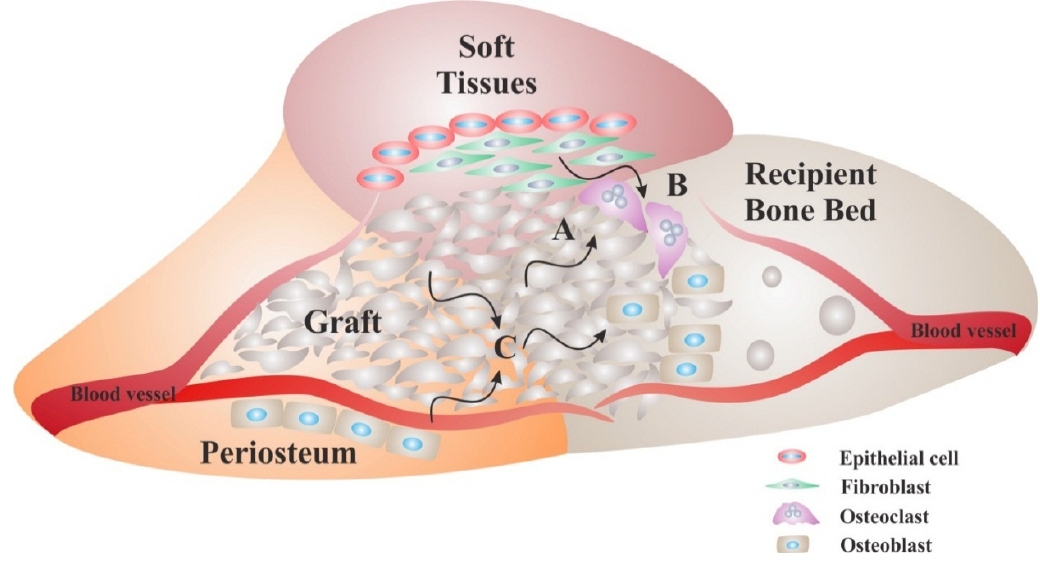
Figure 2. Biological requirements for bone regeneration. Surgical procedures for ridge augmentation are designed based on biological principles of bone